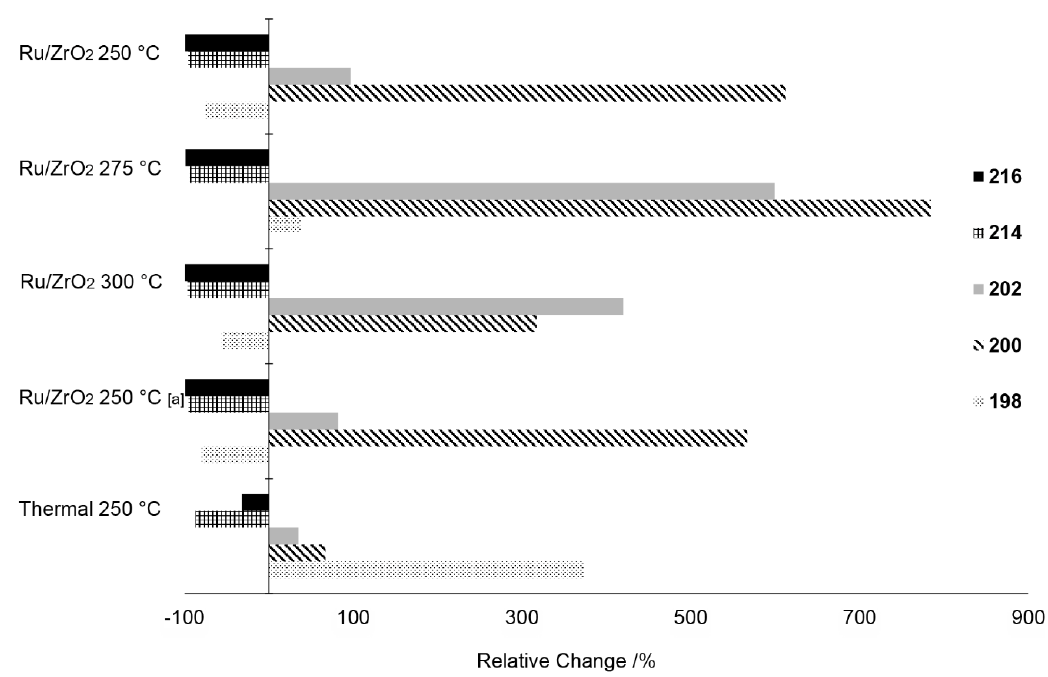
Figure 5. Relative changes of the levulinic acid (LA) dimers obtained with Ru / ZrO 2 catalyst and thermally. Dimer 214 includes both isomers 214a and 214b (Scheme 1). [a] τ b = 1.1 g cat g feed−1 h.